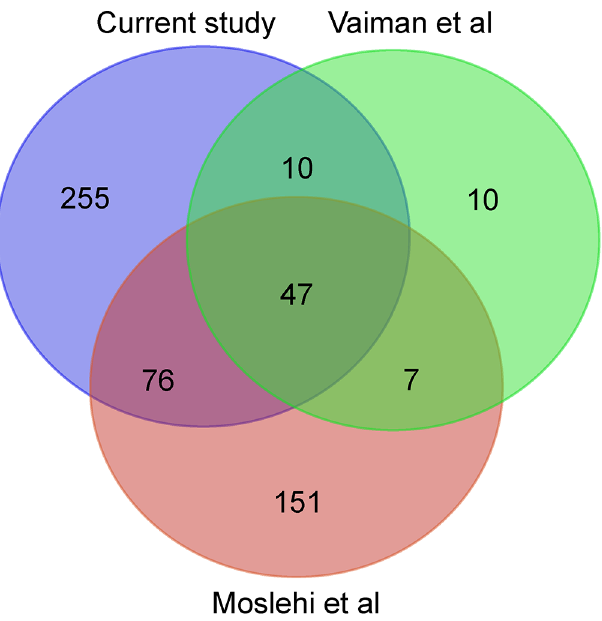
Fig 2. Overlapping genes with previous meta-analyses. Venn diagram of the DEGs from the current study and the previously published studies. DEGs were extracted from the publications [5, 6] and only genes within the gene universe of our study were included in the